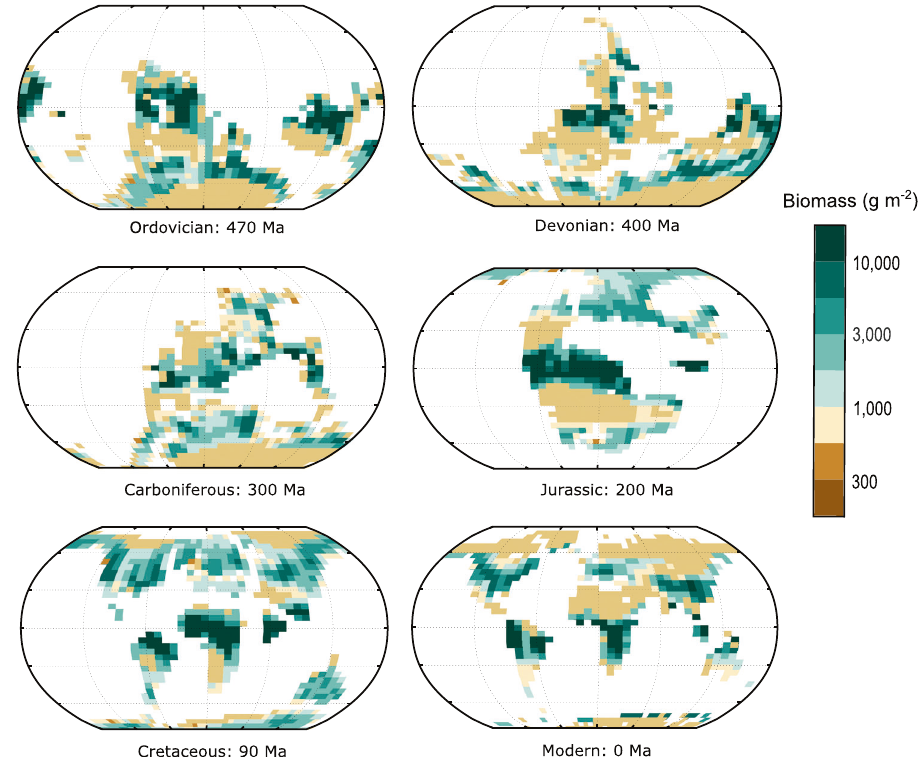
Fig. 5| Globalpotential biomass maps during the Phanerozoic. Mapsshowing a selection ofthe potentialbiomass predictions from this model.Ma:millionyears